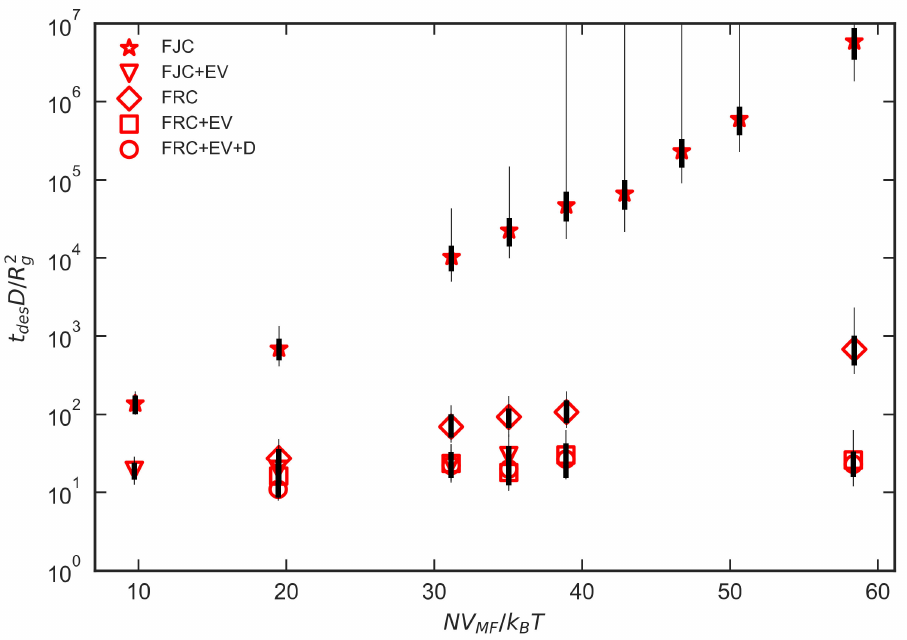
Figure 9. Mean desorption times for chains with ε PW = 0.4 kJ / mol and varying internal potentials. Legend labels correspond to the parameter definitions in Table 1. FJC: freely-jointed chain, FJC + EV: freely-jointed chain with excluded volume, FRC: freely-rotating chain, FRC + EV: freely-rotating chain with excluded volume, FRC + EV + D: freely-rotating chain with excluded volume and dihedral-like potential. The thick and thin error bars are discussed in the caption to Figure